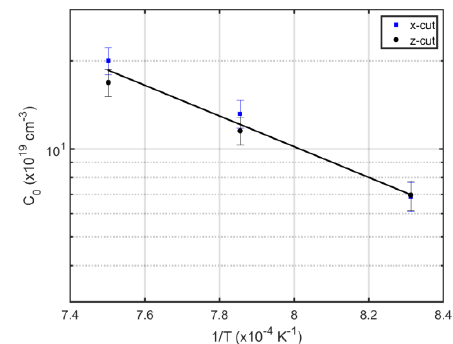
Figure 6. Arrhenius plot of the solubility data of Yb in LiNbO 3 . The line is a fit of the data using Equation (8).